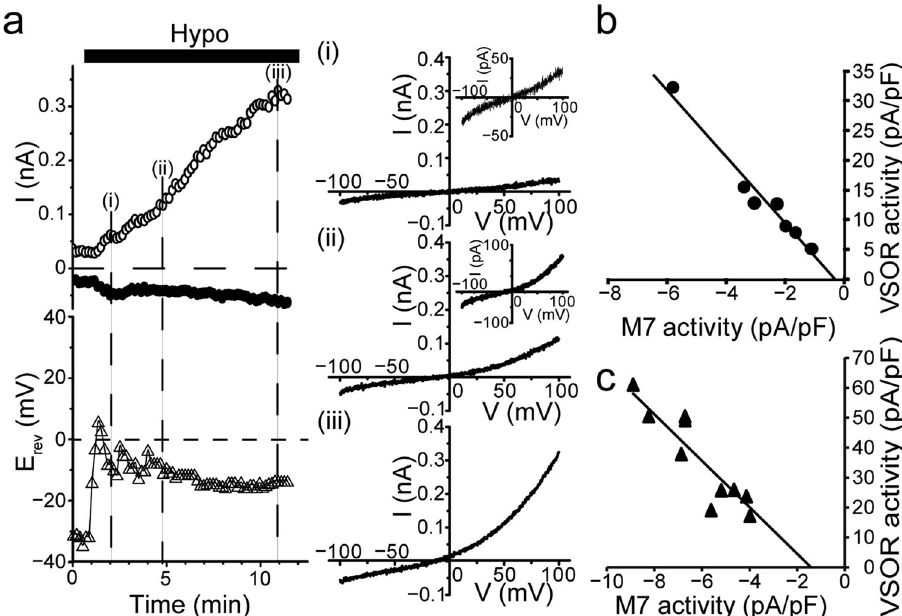
Fig. 6 Real-time simultaneous recordings of TRPM7 and VSOR activity after hypotonic stimulation in DT40 cells. a Whole-cell current response to hypotonic stimulation. Upper left panel shows representative recording exhibiting the time courses of whole-cell currents observed at + 30 mV (open circles) and – 30 mV ( fi lled circles), which correspond to the equilibrium potentials for cations and anions, respectively, under the ionic conditions employed for this recording. Lower left panel shows the reversal potentials ( E rev : open triangles) after application of hypotonic solution ( Hypo ) in WT DT40 cells. Currents were elicited by ramp-clamp (every 10 s at 4 mV/ms). The value of E rev was evaluated by analyzing the measured reversal potentials of the all current traces in response to ramp pulses. Right panels show representative I – V relationships of currents in response to ramp pulses from – 100 to + 100 mV applied at (i), at (ii), and at (iii) in the left panel. Insets represent I – V curves expanded in the y -axis direction. b, c Relationships between the mean peak current densities recorded at + 30 mV ( VSOR activity ) and those at – 30 mV (M7 activity) ( n = 7) in WT DT40 cells ( b ) and in gTRPM7- de fi cient DT40 cells complemented with hTRPM7 ( c ( + Δ -kinase ) and K1648R ( + K1648R ) also showed similar stain- of hTRPM7 con fi rmed the hTRPM7 channel protein expression ing patterns, although fewer + Δ -kinase cells were positively in DT40 cells. In fact, as shown in Fig. 8c and Supplementary stained (Fig. 8b). By contrast, when gTRPM7 was knocked out, Fig. 4a, gTRPM7-de fi cinet DT40 cells complemented with WT no Alexa-488 fl uorescence could be seen in cells (Fig. 8a: KO ). TRPM7 or the K1648R mutant also showed bands of similar size Next, western blot analysis using an antibody against the HA tag ( + WT, + K1648R ), but gTRPM7-de fi cient DT40 cells